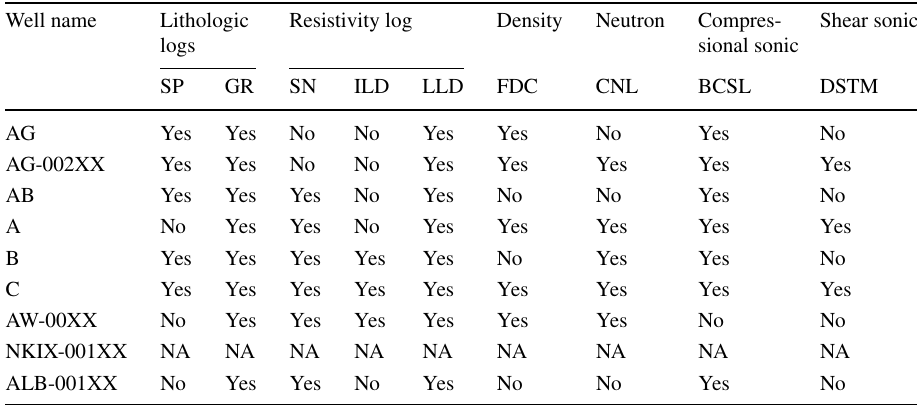
Table 2 Data quality chat from wells in BUMMA